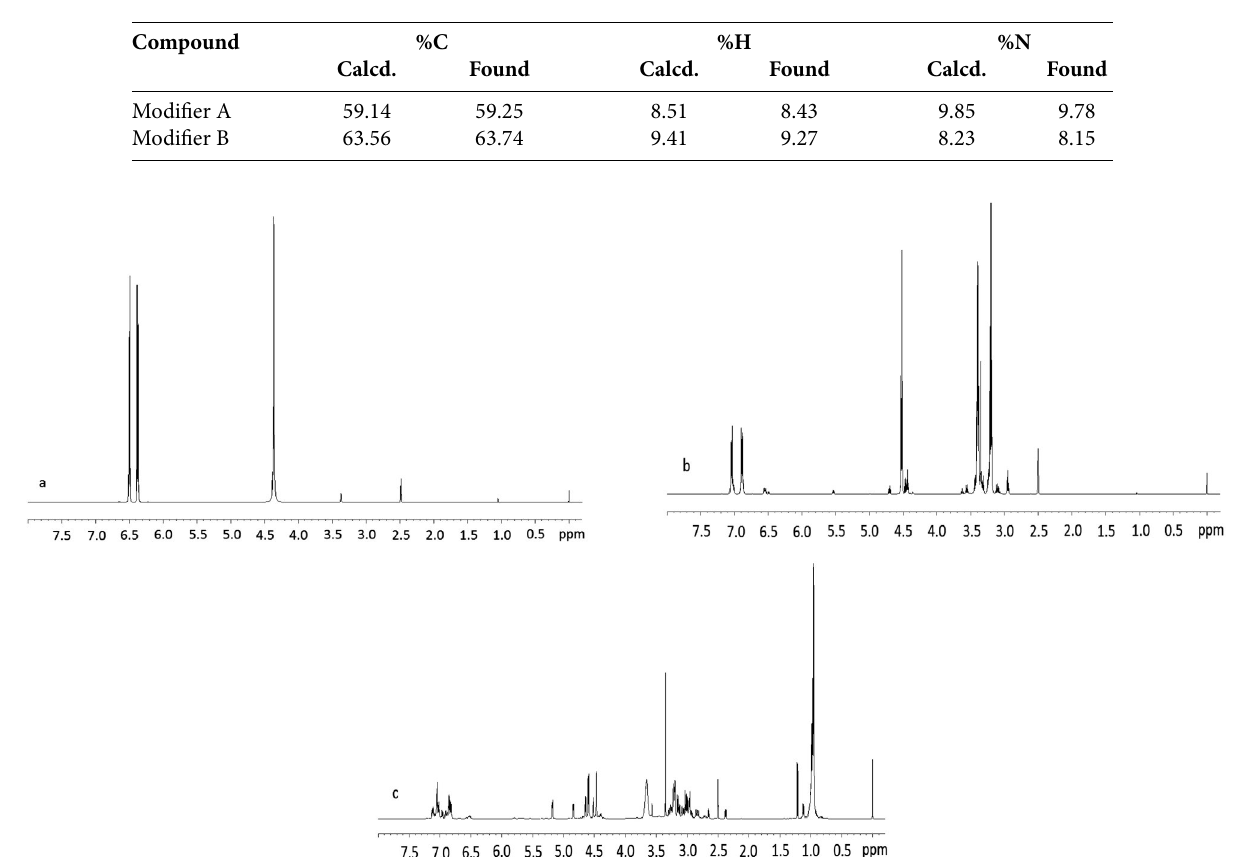
Table 4. Elemental Analysis of Modifiers